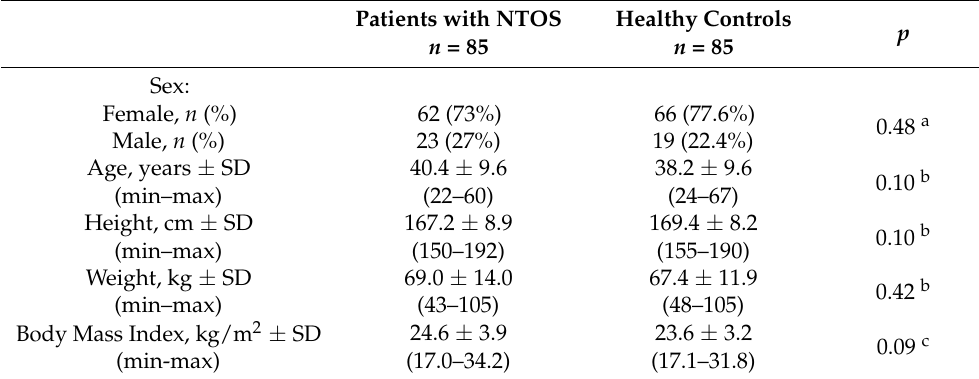
Table 2. Comparison between patients with neurogenic TOS and healthy controls.